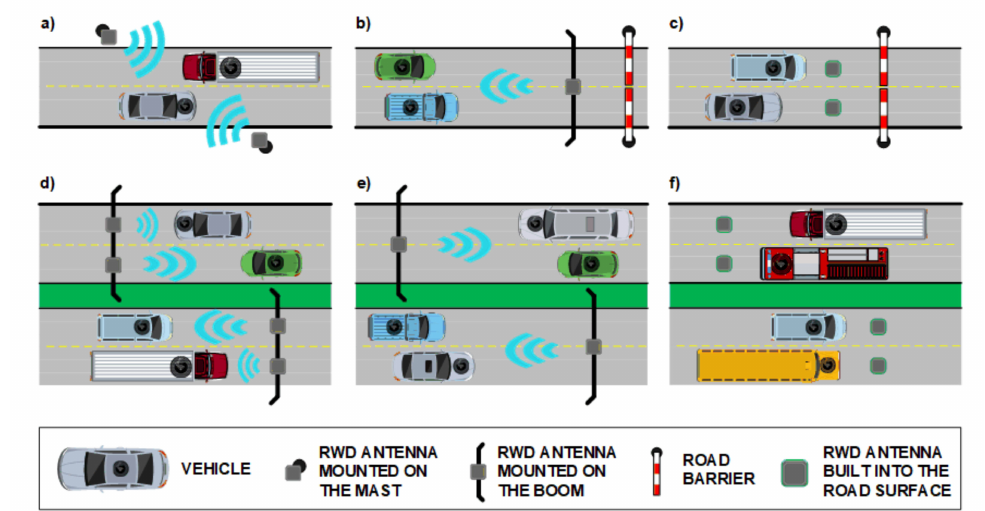
Figure 3. RWD antenna set-up in the tra ffi c infrastructure: ( a ) on masts; ( b ) on boom; ( c ) built into road surface; ( d ) covering a single tra ffi c lane; ( e ) covering multiple lanes; ( f ) built into the surface of multiple tra ffi c